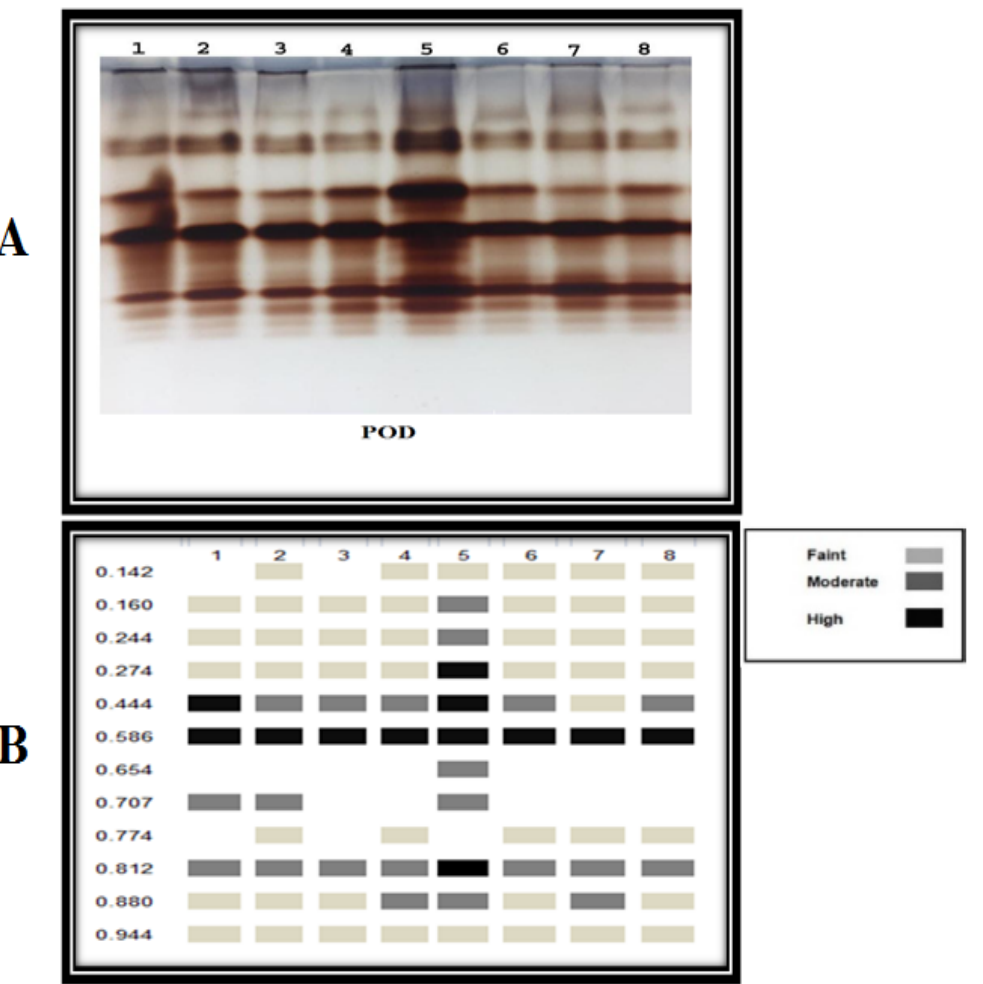
Figure 7. The effect of F. oxysporum and the application of cyanobacteria on ( A ) Peroxidase isozyme. ( B ) Ideogram analysis of POD isozyme of the infected pepper plants. 1 = Healthy control; 2 = Infected control; 3 = Infected plant + D. muscorum (soil); 4 = Infected plant + A. oryzae (soil); 5 = Infected plant + A. platensis (soil); 6 = Infected plant + D. muscorum (foliar); 7 = Infected plant + A. oryzae (foliar); 8 = Infected plant + A. platensis (foliar).